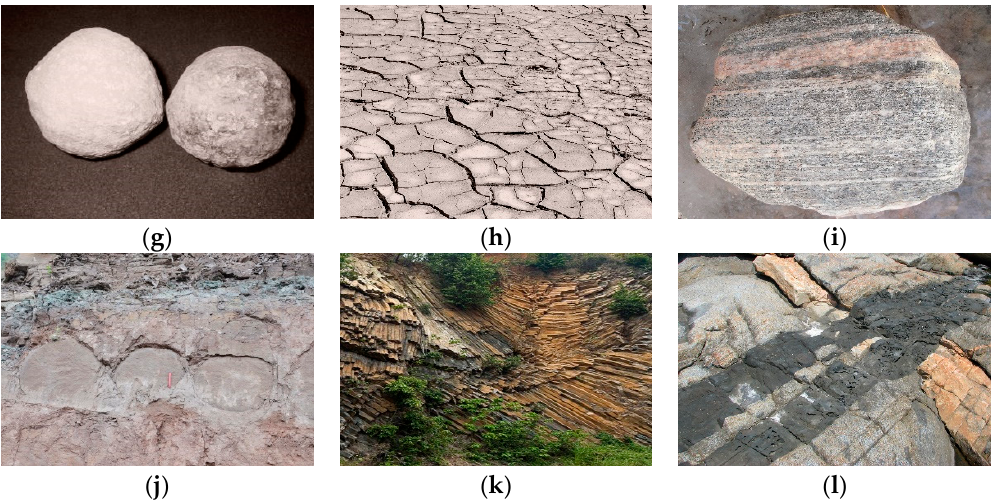
Figure 1. Samples of geological structure images: ( a ) Anticline; ( b ) Ripple marks; ( c ) Xenolith; ( d ) Scratch; ( e ) Ptygmatic folds; ( f ) Fault; ( g ) Concretion; ( h ) Mudcracks; ( i ) Gneissose structure; ( j ) Boudin; ( k ) Basalt columns; ( l ) Dike.